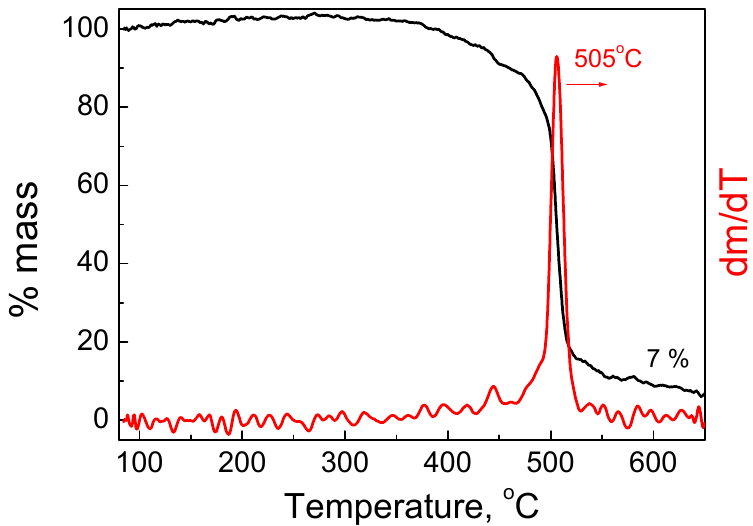
Figure 4. TGA (black line) and differential curve, dm/dT, (red line) of biochar. TGA was performed under air atmosphere at 10 °C min − 1 heating rate.